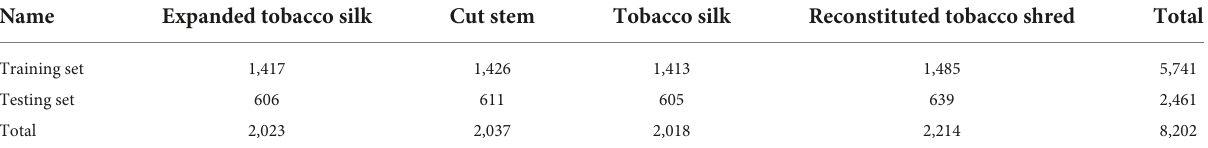
TABLE 5 Details of tobacco shred dataset.